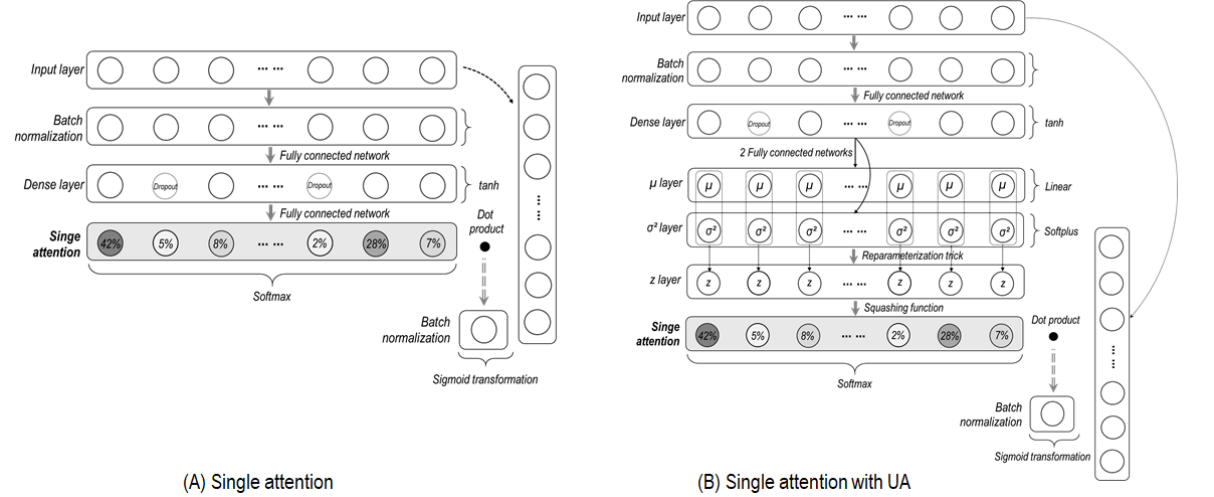
Figure 3. Model designs for single attention mechanisms. UA: uncertainty awareness. The concept of "reparameterization trick" is described in Concept A1 of Multimedia Appendix